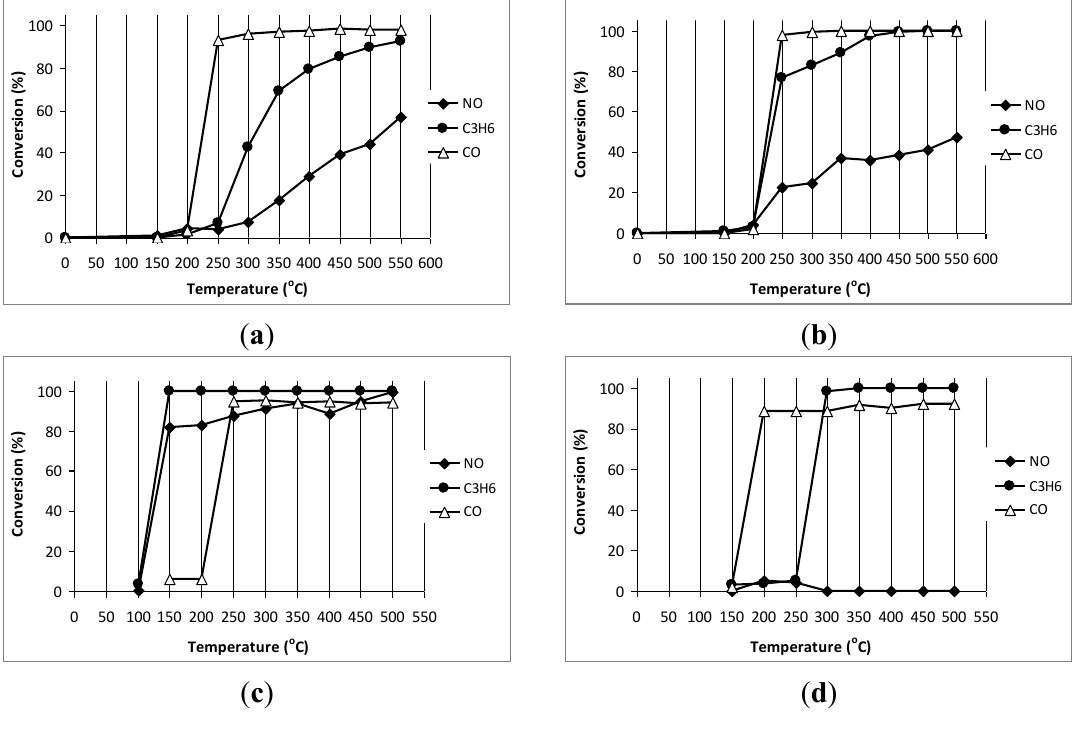
Figure 8. Catalytic activities for the treatment of CO, C ( a ) MnO –NiO–Co O /cordierite (Ca.2); ( b ) MnO 2 3 4 ( c ) unsupported MnO –NiO–Co 2 cordierite substrate